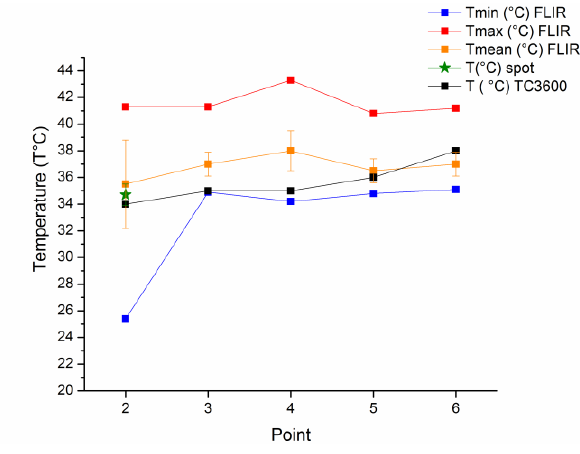
Figure 7. TC3600 thermal spots (black) are compared with FLIR apparent temperature values: maximum temperature are in red, minimum temperature are showed in blue and mean